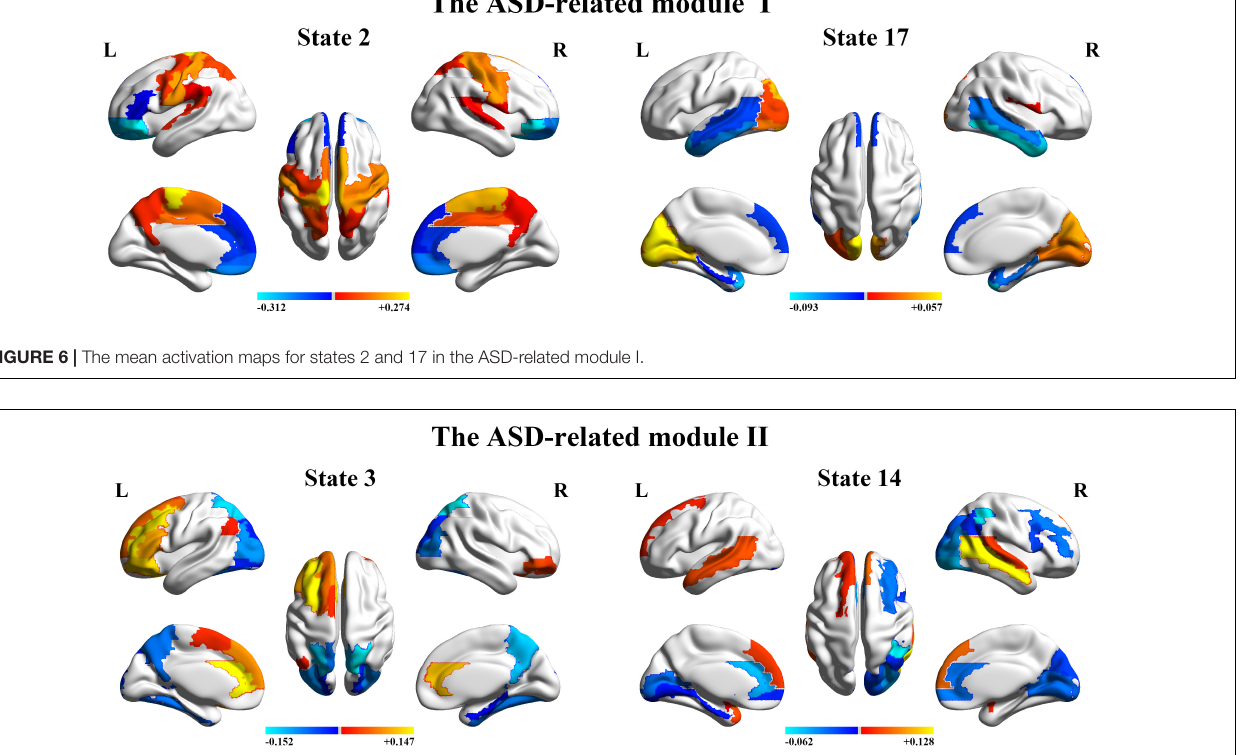
FIGURE 7 | The mean activation maps for states 3 and 14 in the ASD-related module